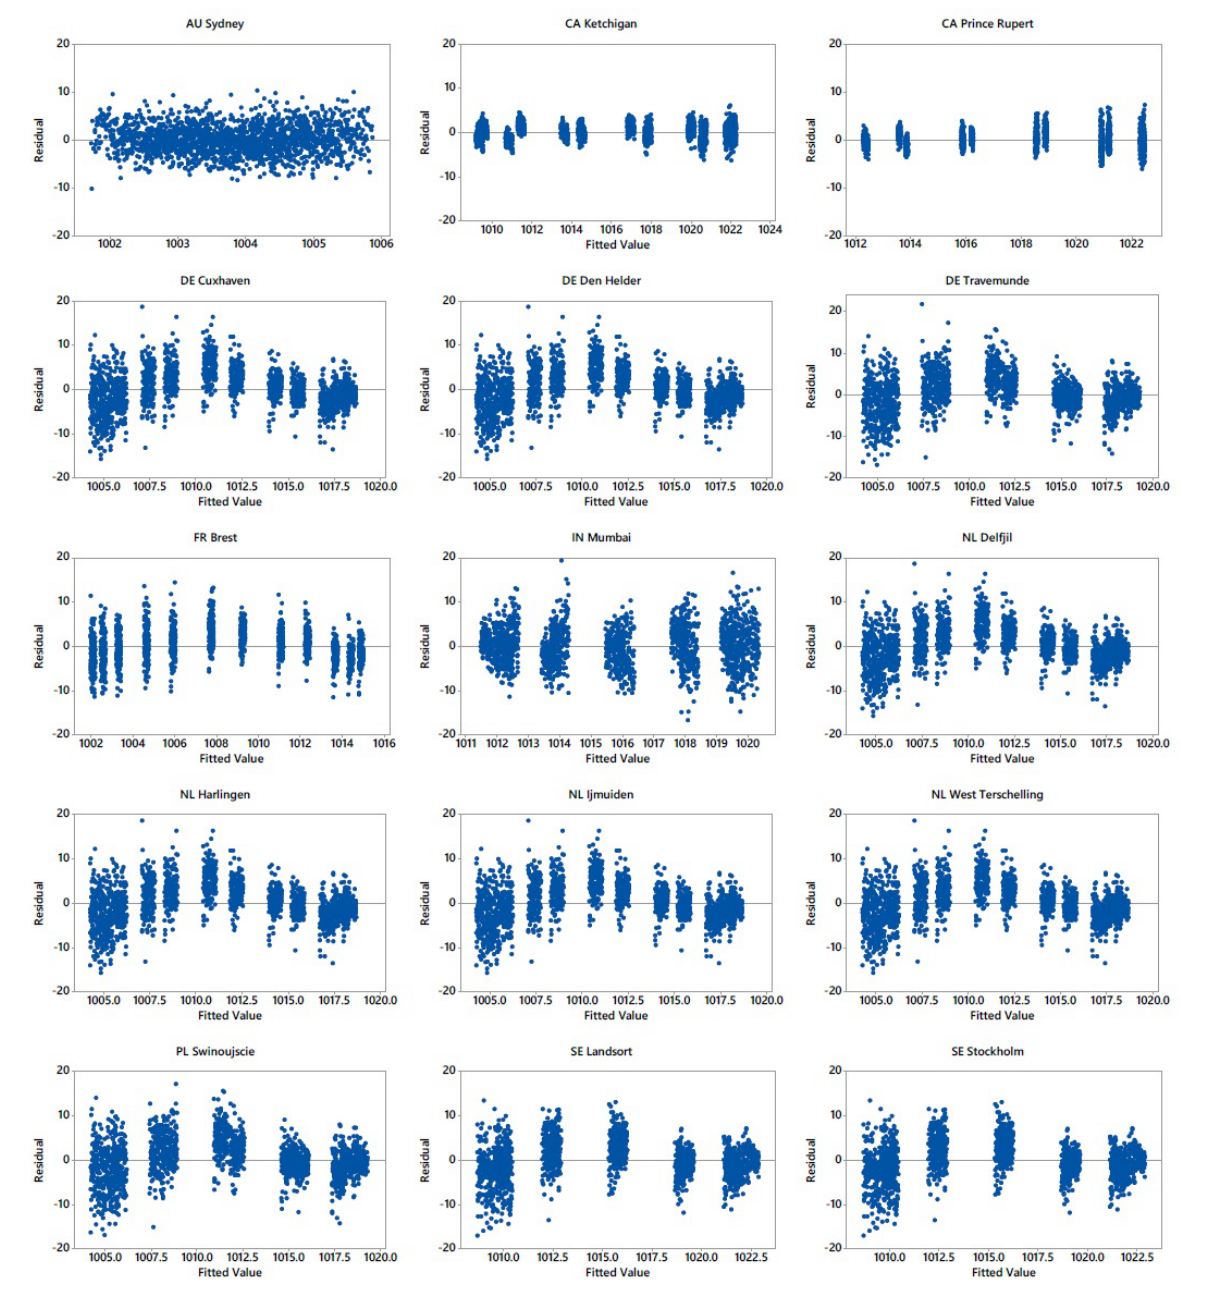
Figure 5: Residual atmospheric variations at all 27 globally distributed tide gauge stations were calculated using a preliminary model with a deterministic trend, and the sine and cosine components of annual periodicities superimposed with a homoscedastic noise. Note that some of the plots are identical because some stations share the same regional atmospheric pressure data.